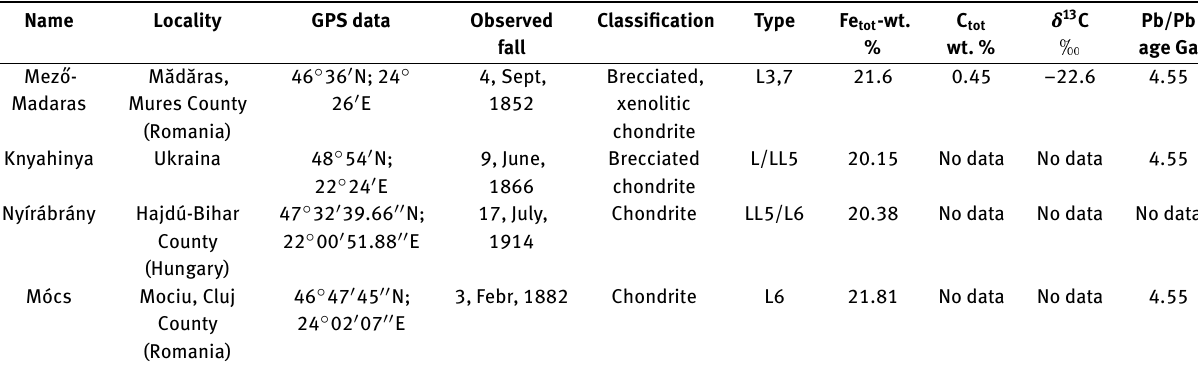
Table 1. The studied meteorites and their characterization (Eötvös University Meteorite Collection, Budapest) (Grady et al. , 1982; Graham et al. ,